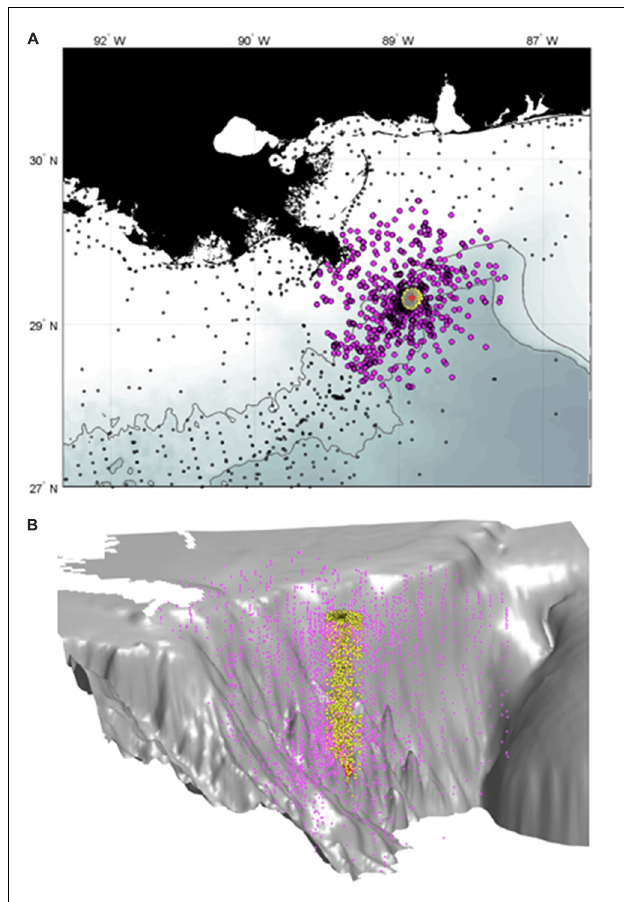
FIGURE 1 | BP Gulf Science Data (GSD) Water Chemistry Data stations collected during the Deepwater Horizon (DWH) blowout from May to December 2010. (A) Stations located within 100 km (magenta stations, n = 7,741) and 10 km (yellow stations, n = 3,464) perimeters from Macondo (red+) are used to analyze the daily vertical distribution of low (C5–C12) and high (C13+) molecular weight petroleum hydrocarbons, and to evaluate subsea dispersant injection (SSDI) volumes on the vertical distribution of polycyclic aromatic hydrocarbons (PAHs) around the response area, respectively. Green dots are GSD stations outside the study area ( n = 5,477). The gray lines are at the 1,000 and 2,000 m isobaths. (B) Three-dimensional view of the selected stations relative to Macondo wellhead’s depth (red circle, not to